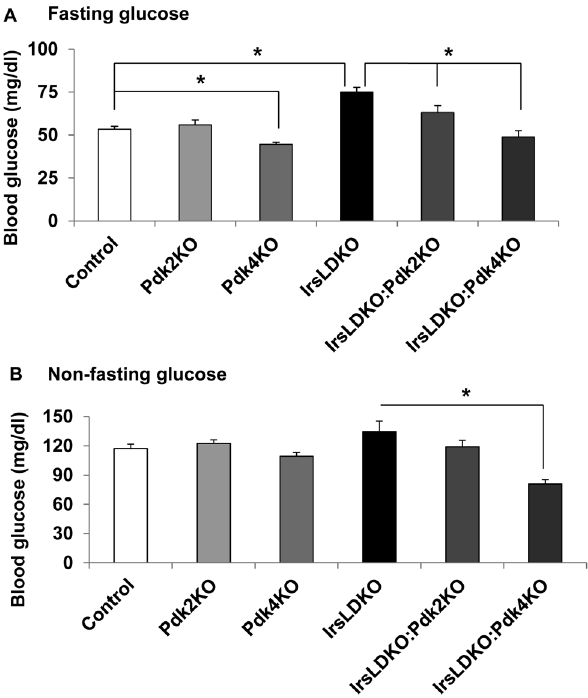
Figure 2. Deletion of the Pdk4 gene improves hyperglycemia in IrsLDKO mice. A, Blood glucose was measured in overnight fasted control and knockout mice. B, Blood glucose was measured in ad libitum fed control and knockout mice. Data are presented as means 6 SEM, n=8–23. *, P , 0.05 relative to corresponding controls.